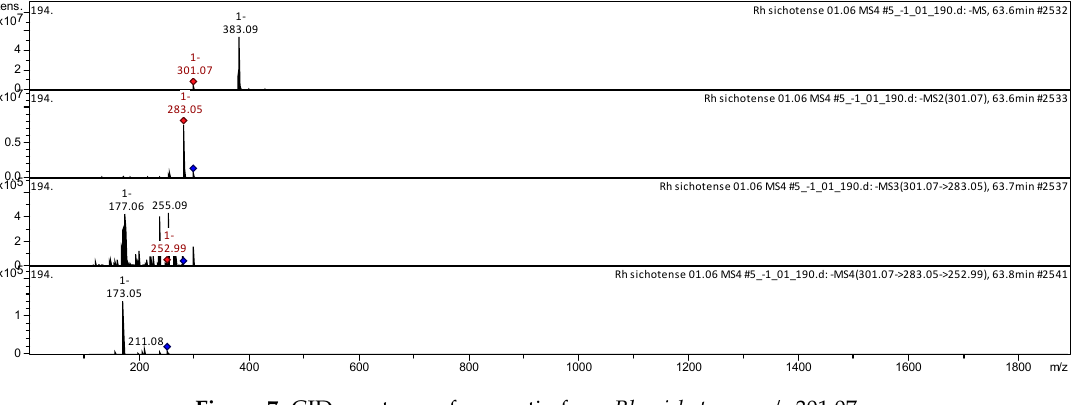
Figure 7. CID spectrum of quercetin from Rh. sichotense , m / z 301.07.